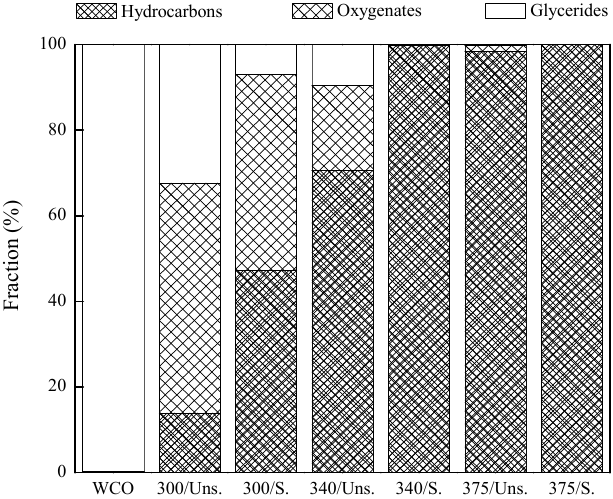
Figure 3. Fraction distribution of liquid products hydrotreated by unsupported and supported CoMoS catalysts. * The number is reaction temperature; Uns and S mean unsupported and supported CoMoS, respectively. e.g., 340-S: the liquid products are upgraded at 340 ◦ C over supported CoMoS. The same abbreviations are used in the remaining Figures.